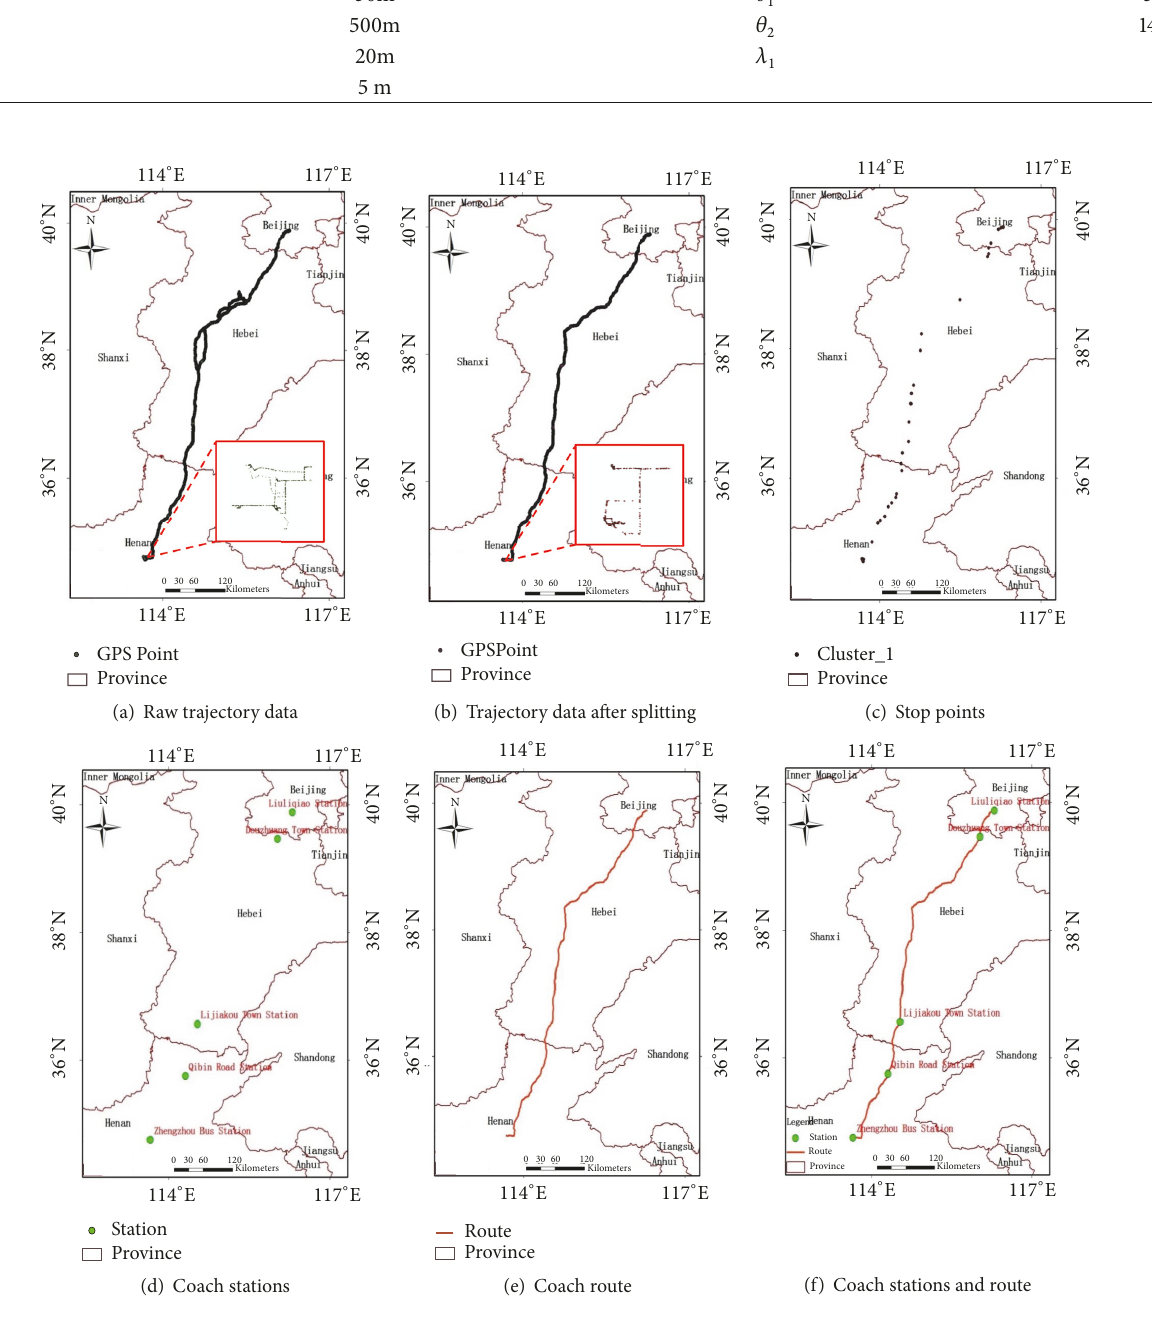
Figure 7: Extraction results at different steps for a coach route (Route